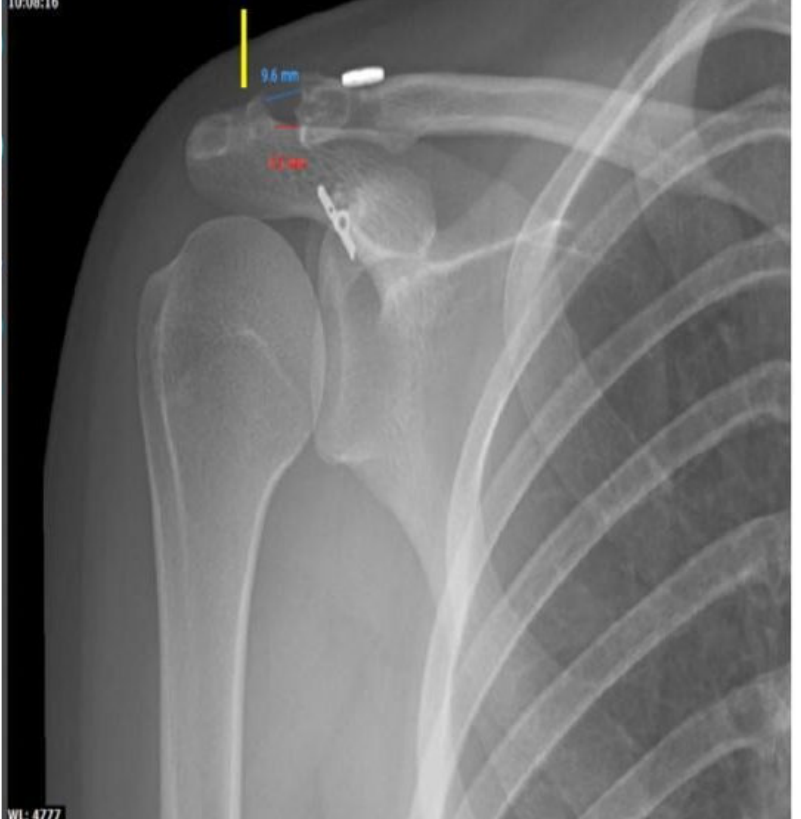
Figure 6. 5.5 years post-surgery radiographic control. Correct acromioclavicular alignment, with increased acromioclavicular space. Yellow arrow: vertical bone tunnel of the tendon plasty.